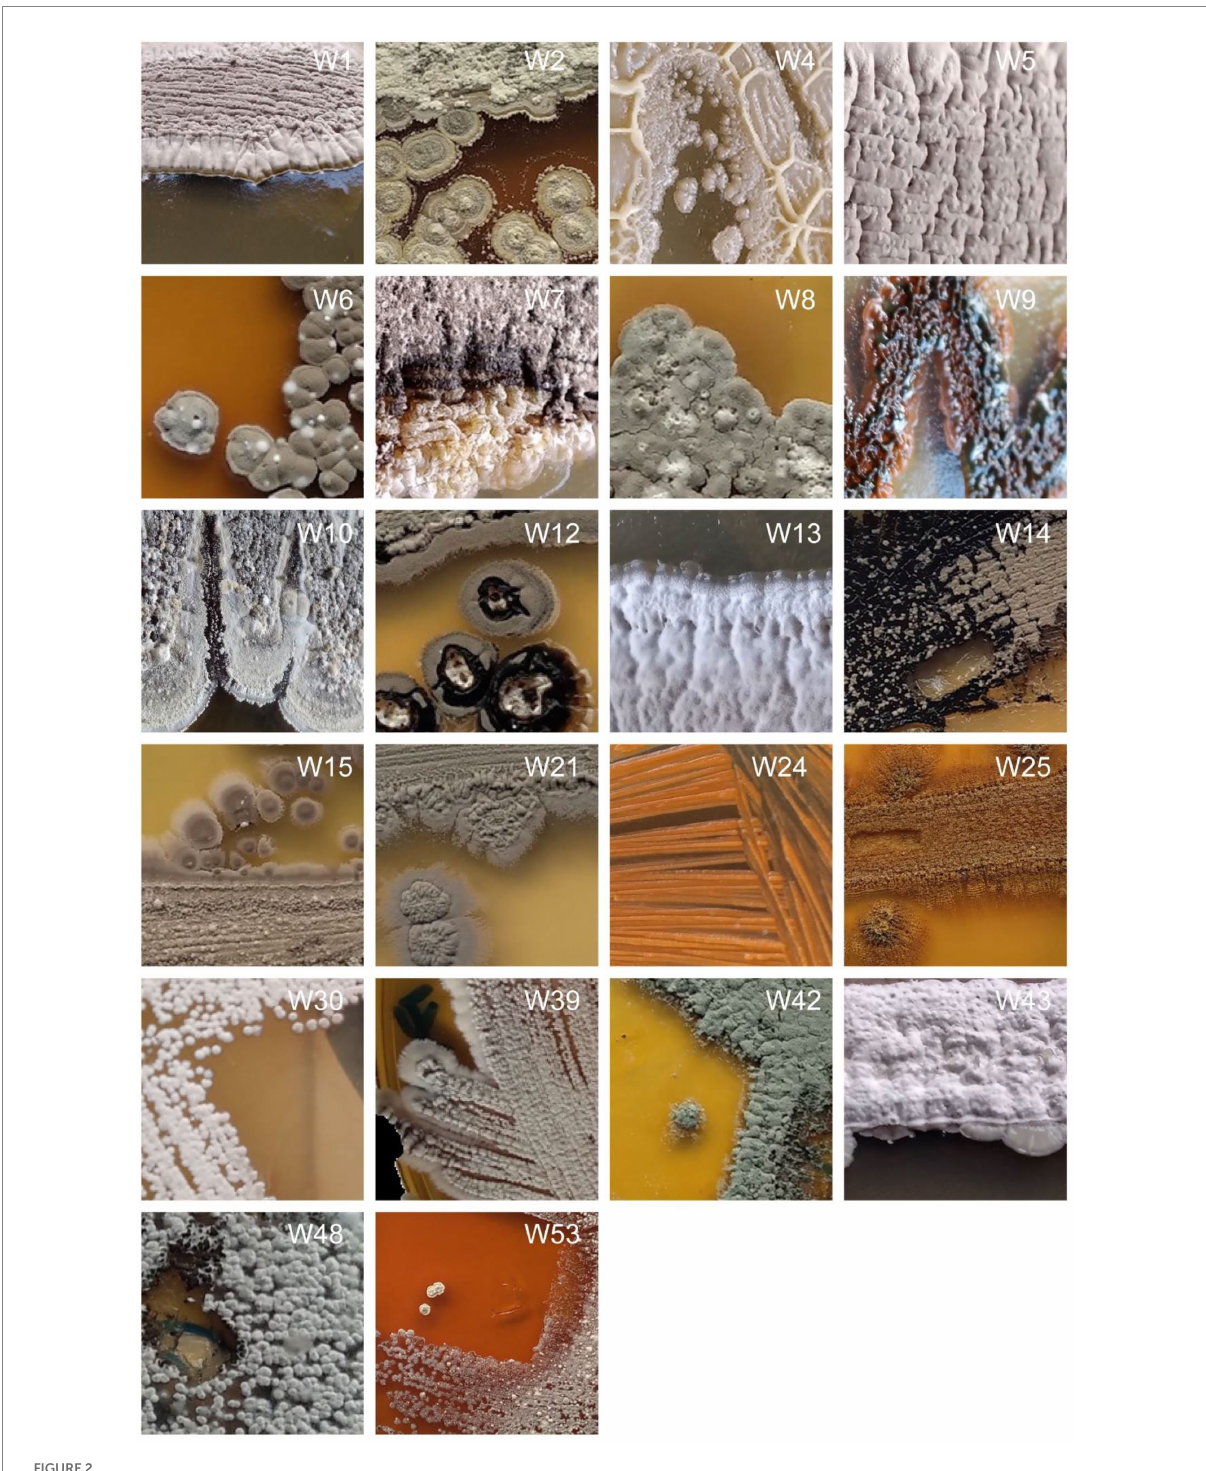
FIGURE 2 Physical appearances of selected strains isolated from the caves on different isolation media. Photographs are not available for all isolated